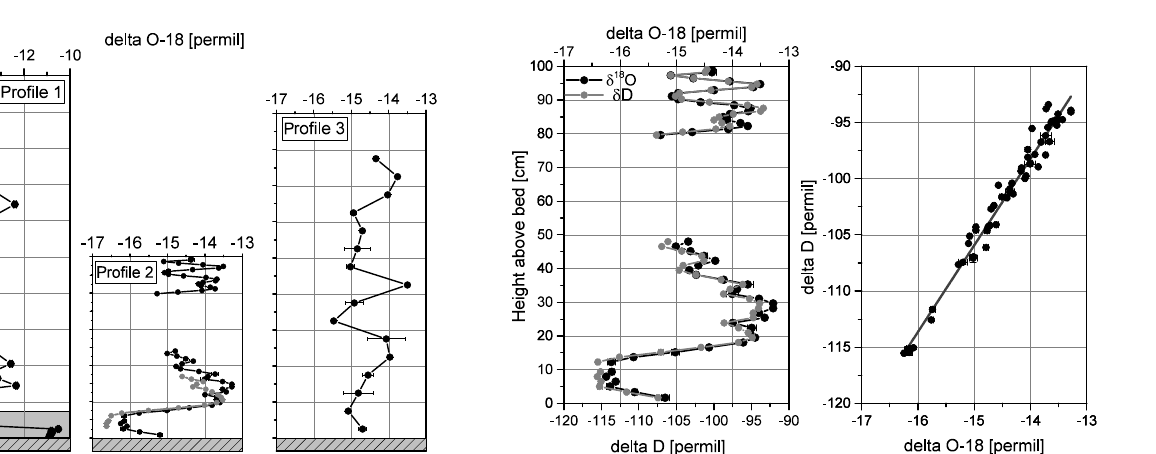
Figure 4. Co-isotopic analysis of profile 2 showing both δ D and δ 18 O in grey and black, respectively (left side). Also shown is the linear regression of δ D vs. δ 18 O, revealing a slope of (7 . 7 ± 0 . 2), in agreement with co-isotopic results previously described by Lorrain and Haeberli